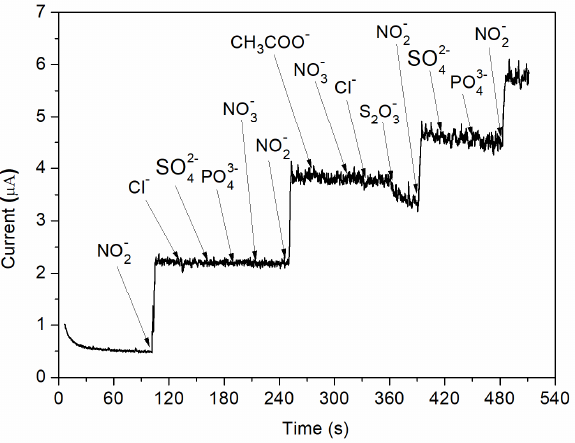
Figure 10. Amperometric response of nitrite and various possible interfering species.